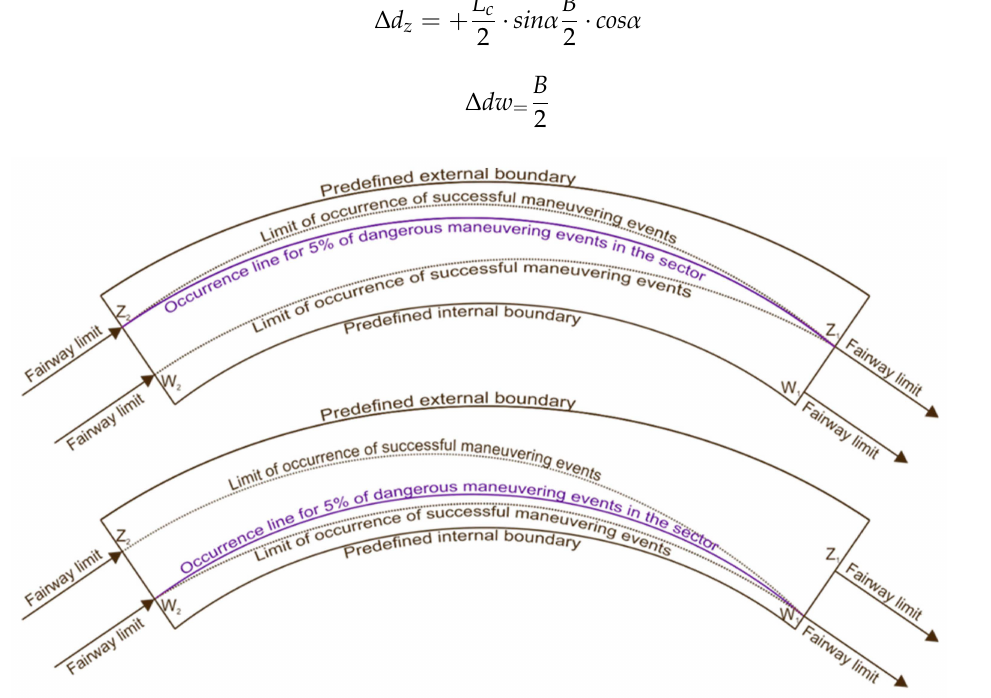
Figure 6. An example distribution of manoeuvring events for one direction of ship movement resulting from numerical